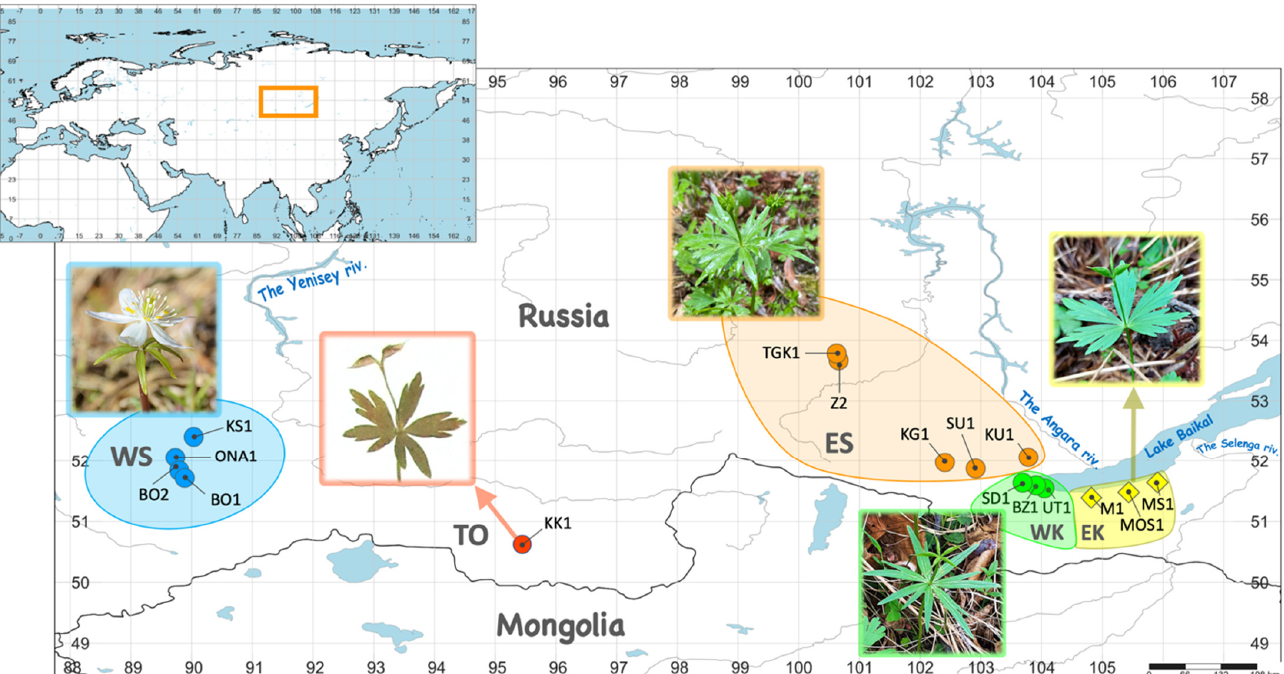
Figure 1. Eranthis sample collection map for DNA analysis. Collection sites (localities) are indicated with colored circles (correspond to E. sibirica according to Erst et al., 2020 [5]) or diamonds (correspond to E. tanhoensis according to Erst et al., 2020 [5]). Abbreviated locality names and numbers correspond to those listed in Table 1. The areas encircled with lines of different colors show the provisional boundaries of the presumable Eranthis range fragments in South Siberia. The contour color and two-letter abbreviations indicate the fragments to which collection sites belong, as follows: EK (yellow)—eastern part of the Khamar-Daban Ridge, ES (orange)—the Eastern Sayan Mountains, TO (red)—the Tannu-Ola Ridge, WS (blue)—the Western Sayan Mountains, WK (green)—western part of the Khamar-Daban Ridge. Map was drawn using SimpleMappr [14], map projection: geographic; datum WGS84.